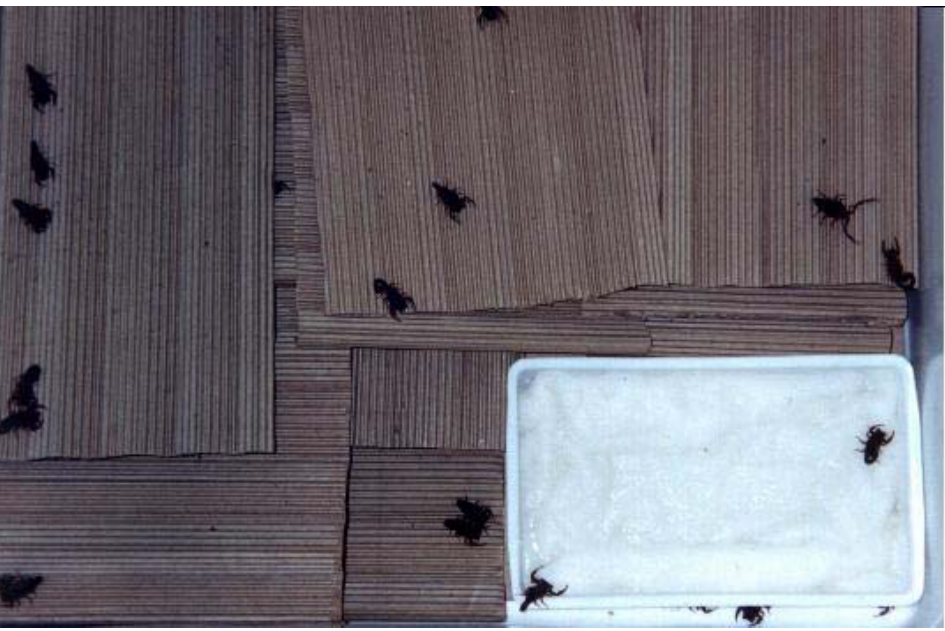
Figure 3 . The scorpion’s box. D. M.